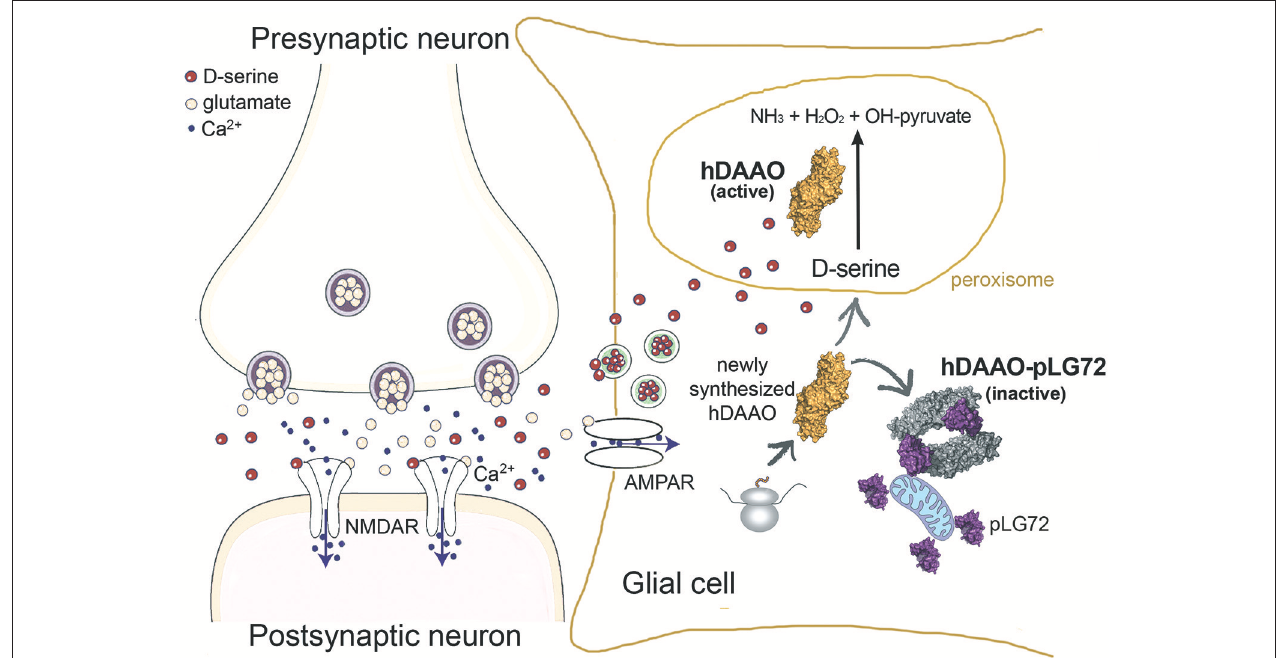
FIGURE 2 | Proposed role of pLG72 on D-serine cellular concentration based on its binding to hDAAO on the cytosolic side of mitochondria in glial cells. An abnormal, lower inhibition of hDAAO activity is due to production of pLG72 variants prone to degradation or with a lower affinity for hDAAO. Hyperactivity of hDAAO generates a nonphysiological decrease in D-serine concentration and, in turn, NMDAR hypofunction.